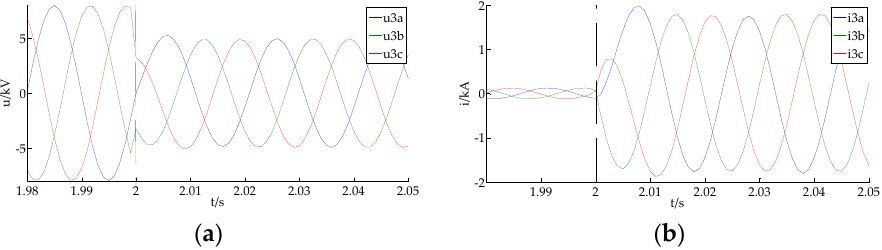
Figure 7. Voltage and current waveforms of Relay 3 during a three-phase fault at k1: ( a ) voltage; ( b ) current.